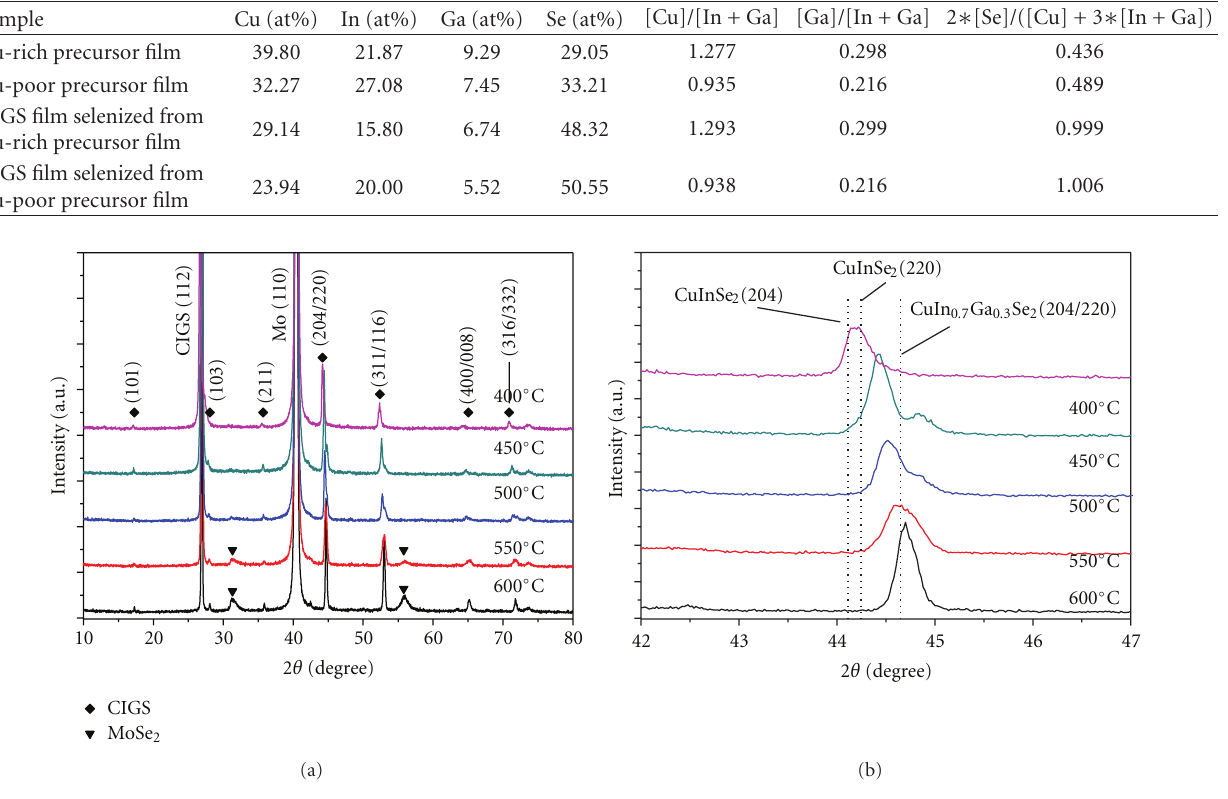
Figure 2: (a) XRD patterns of CIGS films selenized from Cu-rich precursor films at di ff erent selenization temperatures for 30min. (b) Detailed XRD plots of the (204/220) peaks. JCPDS (Joint Committee on Powder Di ff raction Standards) Numbers 42-1120, 29-0914, 40- 1487, and 35-1102 are referred to for Mo, MoSe 2 , CuInSe 2 , and CuIn 0 . 7 Ga 0 . 3 Se 2 ,